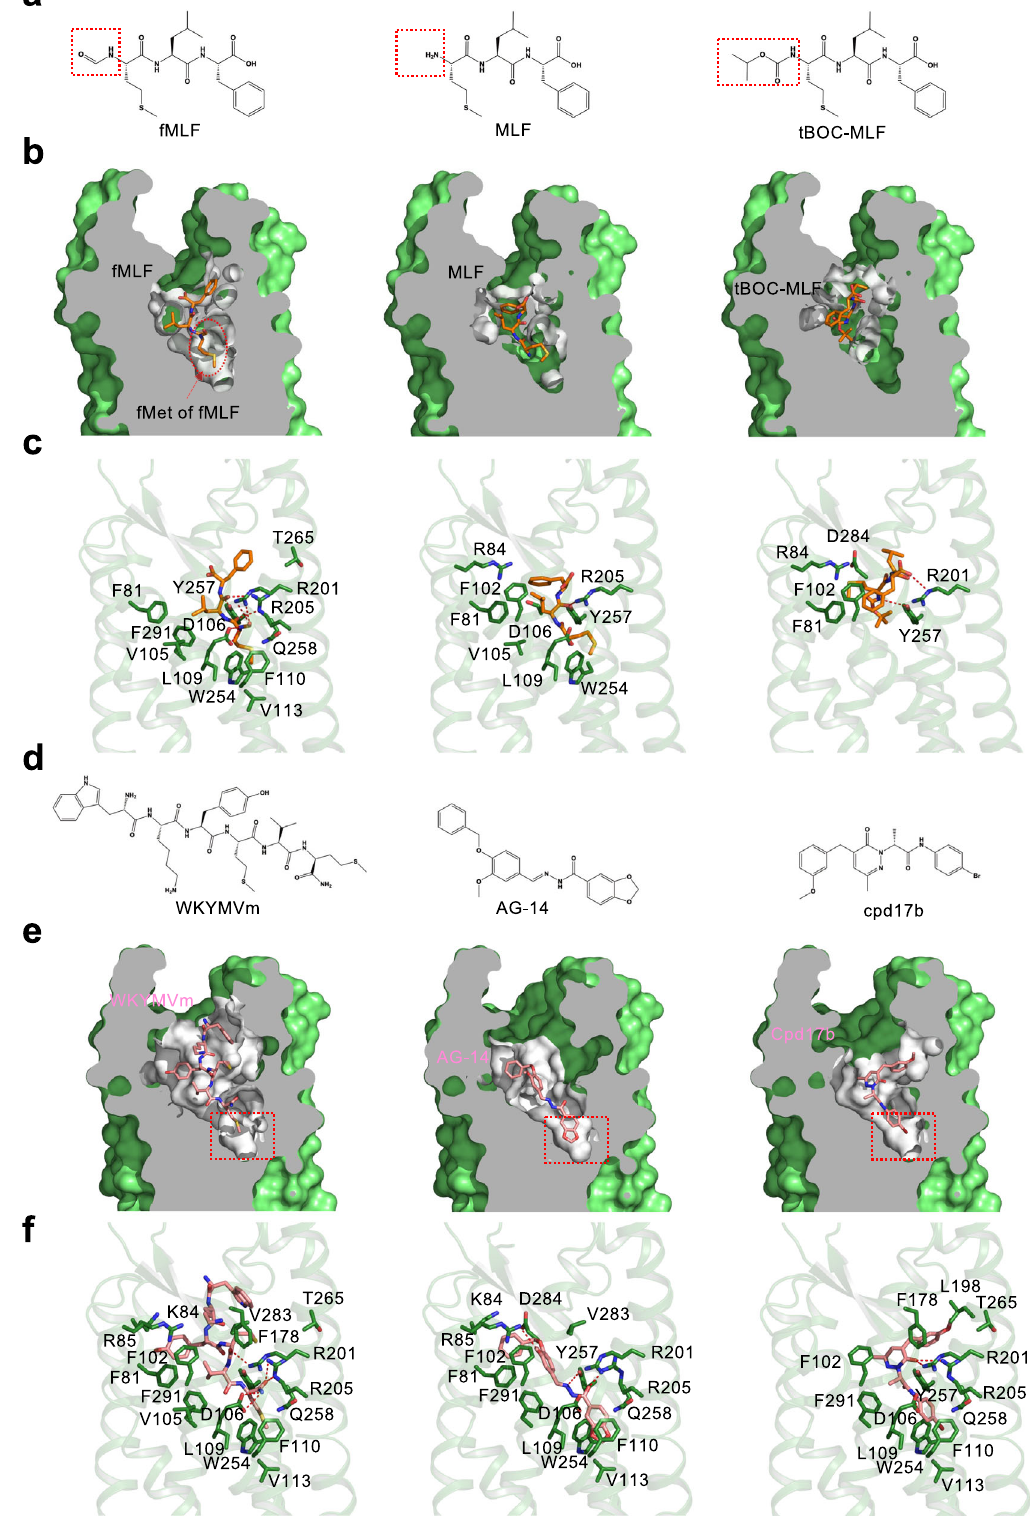
Fig. 4 | Binding posesoffMLF,non-formyl analogsand smallmoleculeligands to FPR1. a Chemical structure of fMLF and its non-formyl analogs. b Slab views of the binding pocket of fMLF (left, cryo-EM model), MLF (middle, docking model), and tBOC-MLF (right, docking model) in FPR1, respectively. The ligands are dis- playedinlicoricewithcarboninorange.Thebindingpocketishighlightedinwhite. c Molecular interaction of bound fMLF (left), MLF (middle), and tBOC-MLF (right)